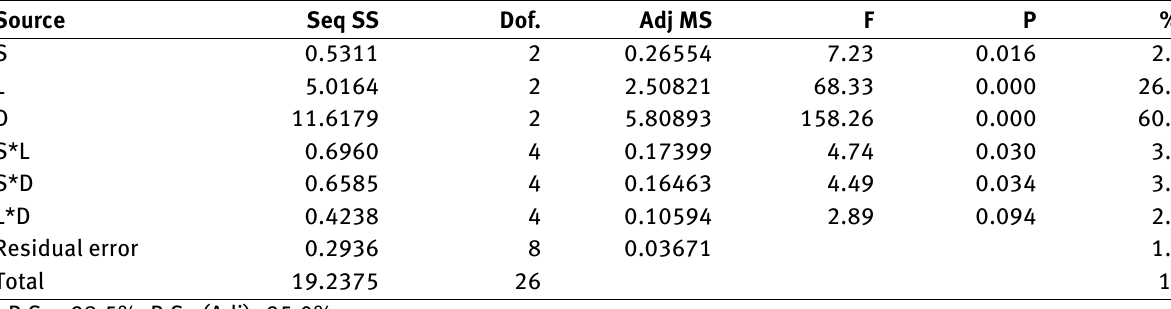
Table 4: ANOVA analysis of Al2219 alloy